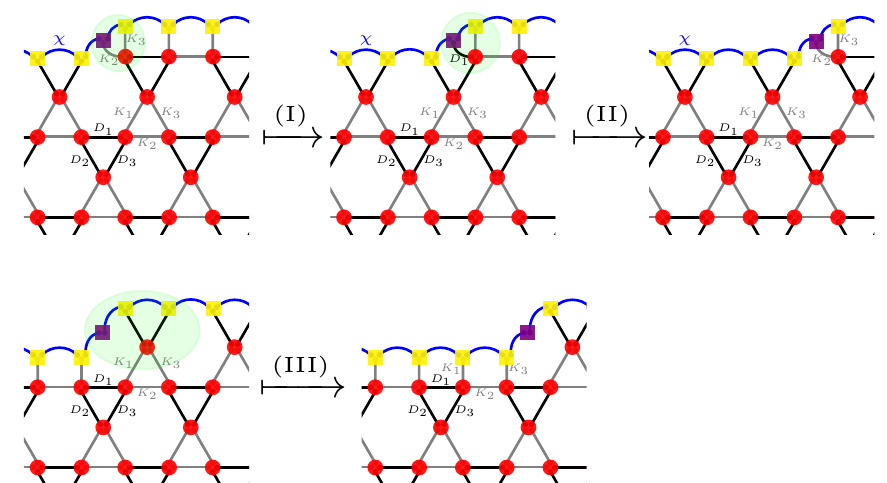
Figure 6: Approximate contraction of a PEPS network on the kagome lattice with the boundary-MPS method. Depending on the position of the local tensor to be con- tracted into the boundary-MPS in the kagome lattice, three different contractions have to be performed. We allow for different bond dimensions for up- ( K downwards ( D ) pointing i